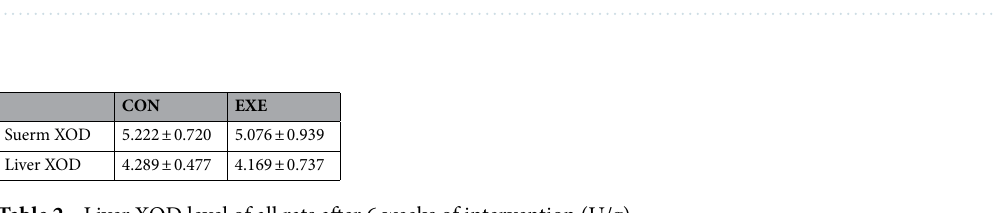
Table 1. Basic information about antibodies.